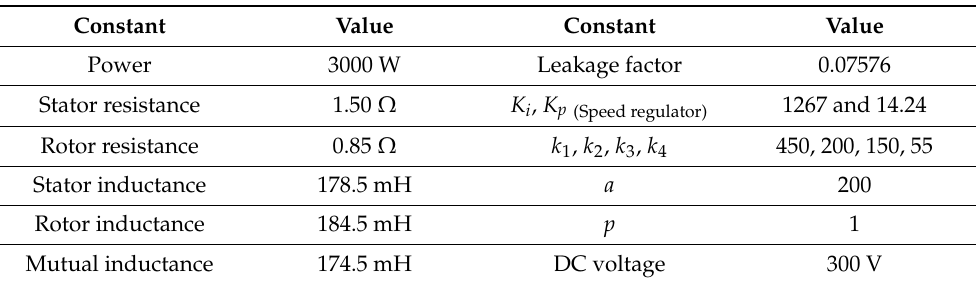
Table A1. IM and control system